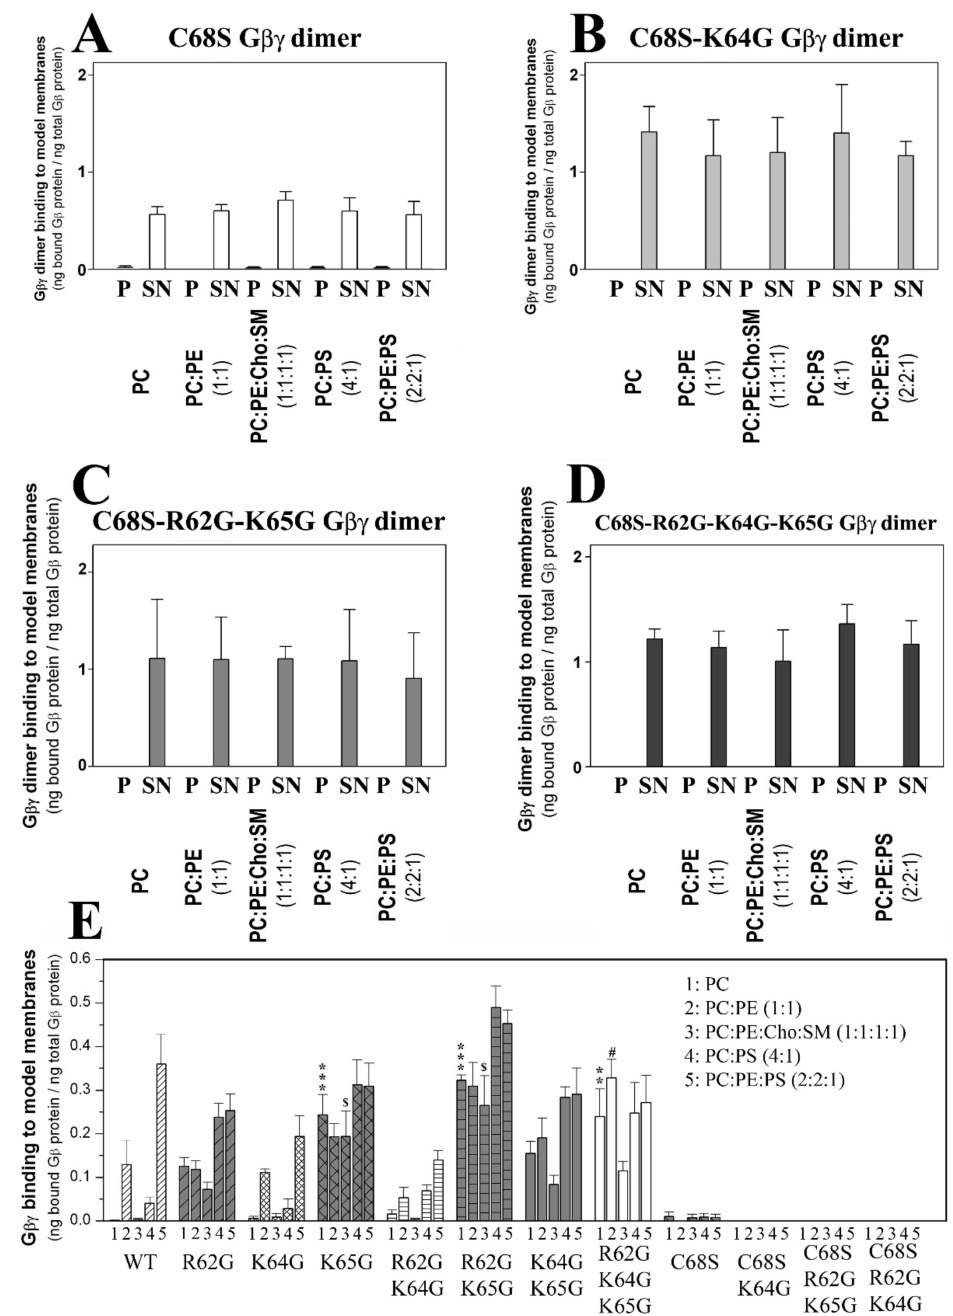
Figure 1. Effect of G γ 2 protein isoprenylation on G βγ –membrane interactions. ( A ), Binding of non-geranylgeranylated G β 1 γ 2 to different model membranes that are representative of biological membrane microdomains. The Cys-68 (C68S) mutation is responsible for impeding geranylgeranyla- tion. ( B ), Binding of the non-geranylgeranylated G β 1 γ 2 dimer carrying gamma-subunit mutations of Lys-64 (K64G mutant) and Cys-68 to model membranes. ( C ), Binding of the non-geranylgeranylated G β 1 γ 2 dimer carrying triple mutations of Arg-62 (R62G), Lys-65 (K65G) and Cys-68 to model mem- branes. ( D ), Binding of G β 1 γ 2 carrying mutations of Arg-62, Lys-64, Lys-65 and Cys-68 to model membranes. In all cases, the binding of the dimer is calculated as the ng of bound G β 1 protein per ng of G β 1 protein in the medium. The molar ratios used are indicated between parentheses. Representative immunoblots of each binding experiment are shown in the Supplemental Material section. The data represent the mean ± S.E.M values. ( E ), G β 1 γ 2 dimer binding to model